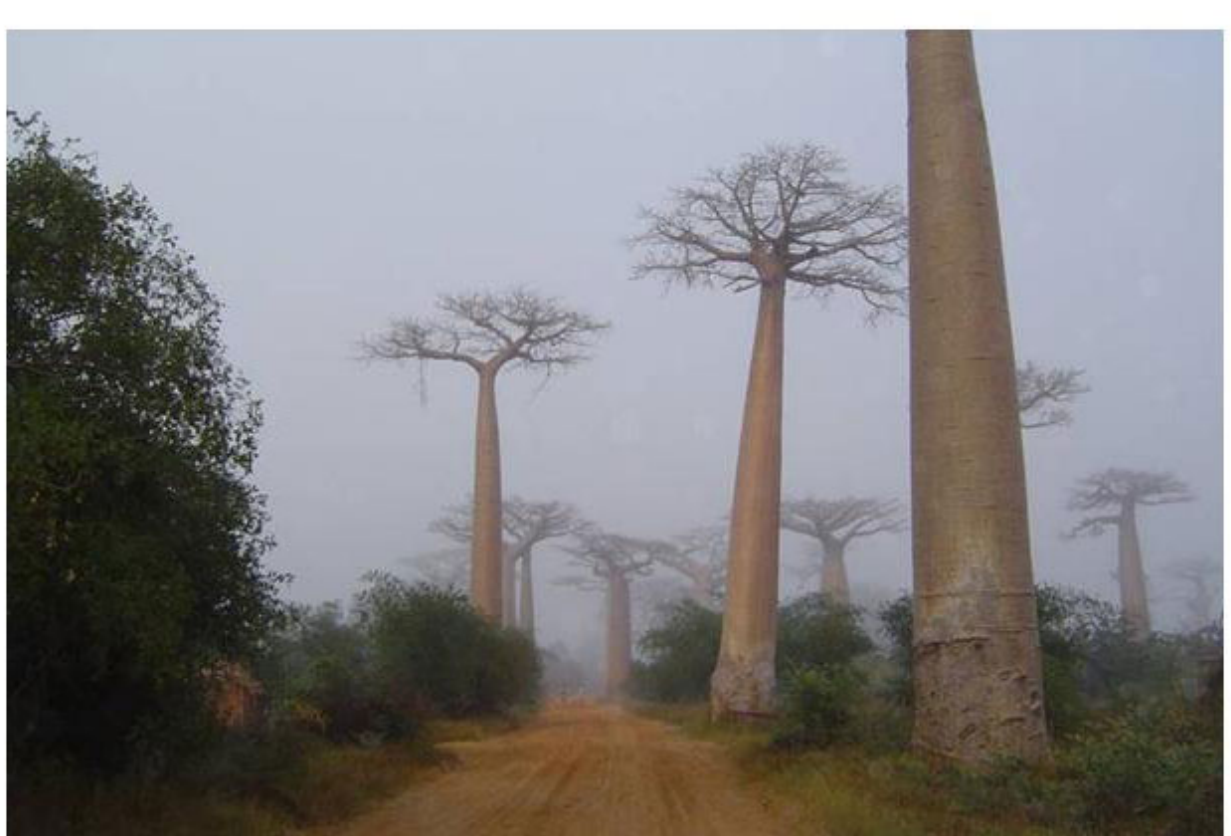
Fig. 3 . Baobob Alley in Central